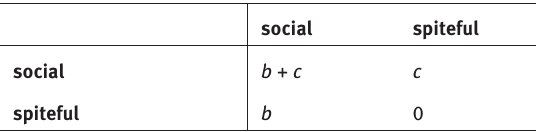
Table 2: The Prisoner’s Delight game where c > 0 represents the cost of spite and b > 0 represents the harm from spite (i.e., spiteful behavior “removes” this payoff). Payoffs are symmetric and shown only for the row-player. Payoffs have been renor- malized to avoid negative